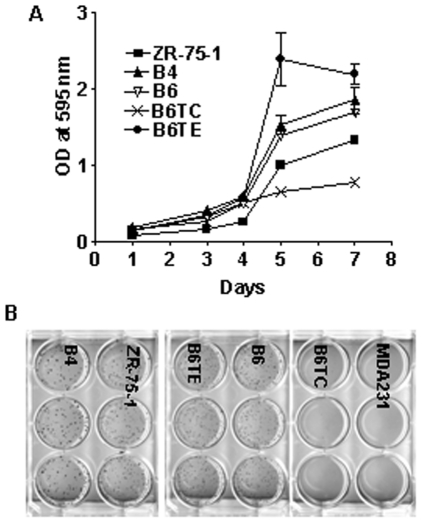
Comparison of in vitro growth property of B6TC cell with other cells.(A) Cells were plated in a 96-well plate at 2,000 cells per well. After 5 days of incubation, relative cell number in each well was determined with MTT assay as reflected with absorbance at 595 nm. The data are presented as mean±SEM from four replicate wells. (B) Anchorage independent growth property of the depicted cell lines was compared with a soft agarose assay. The cells were suspended in 0.4% soft agarose and plated at 1,000 cells per well. After 3 weeks of incubation, the colonies were visualized with p-iodonitrotetrazolium violet staining.